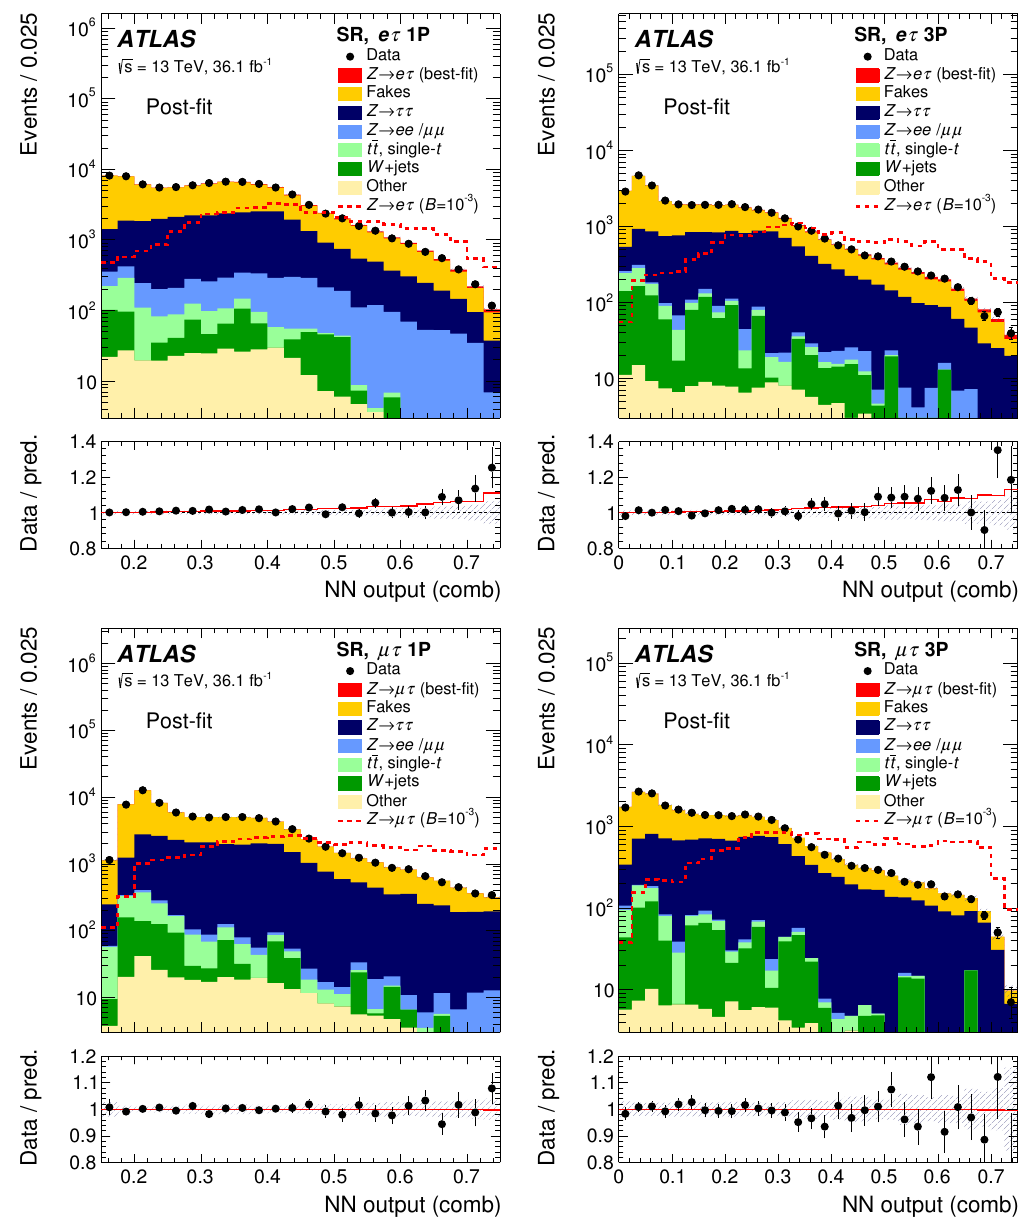
Figure 5: The distribution of the Neural Network classifier score for the Z → e τ (top) and Z → µτ (bottom) searches divided between the 1p and 3p decays respectively [ 17 ] . The lower panels quantify the agreement between background model and data. For the Z → e τ , the signal fixed to the best-fit branching ratio plus background is represented on this plot as a red